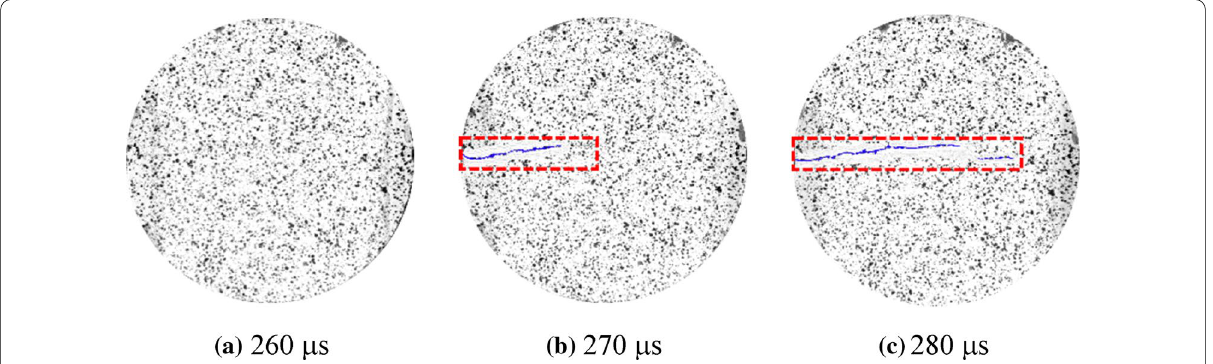
Fig. 11 Crack initiation at the end of PP-1.5-3-2